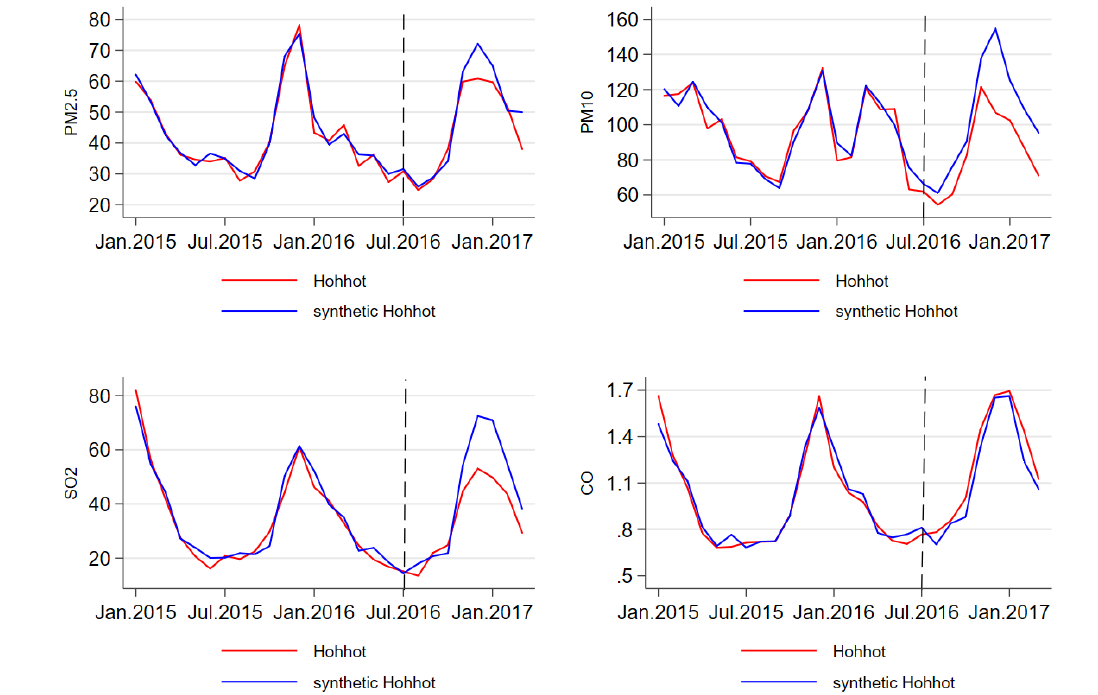
Figure 6. Individual pollutants in treatment regions and synthetic regions.